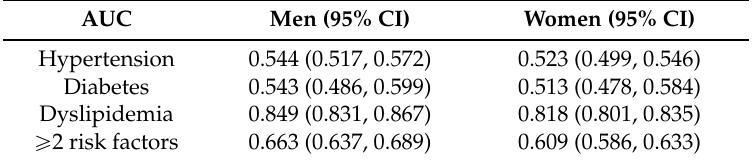
Table 6. AUC of each cardiovascular risk factor in men and women in the Uygur